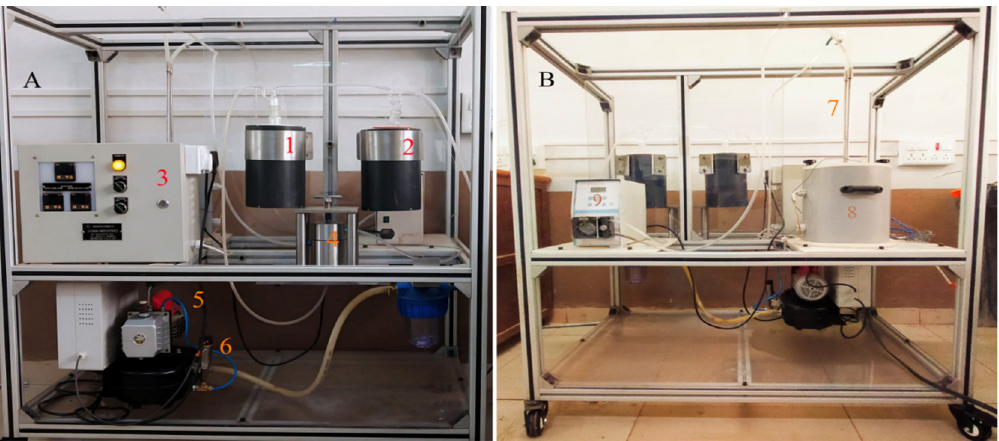
Figure 11. Photographic image of the pervaporation apparatus. ( A ) Front view: (1) permeate cold trap; (2) moisture cold trap; (3) control panel; (4) pervaporation cell; (5) vacuum pump; (6) vacuum control sensor. ( B ) Back view: (7) inlet and outlet of the feed tank; (8) feed tank; (9) circulation pump .